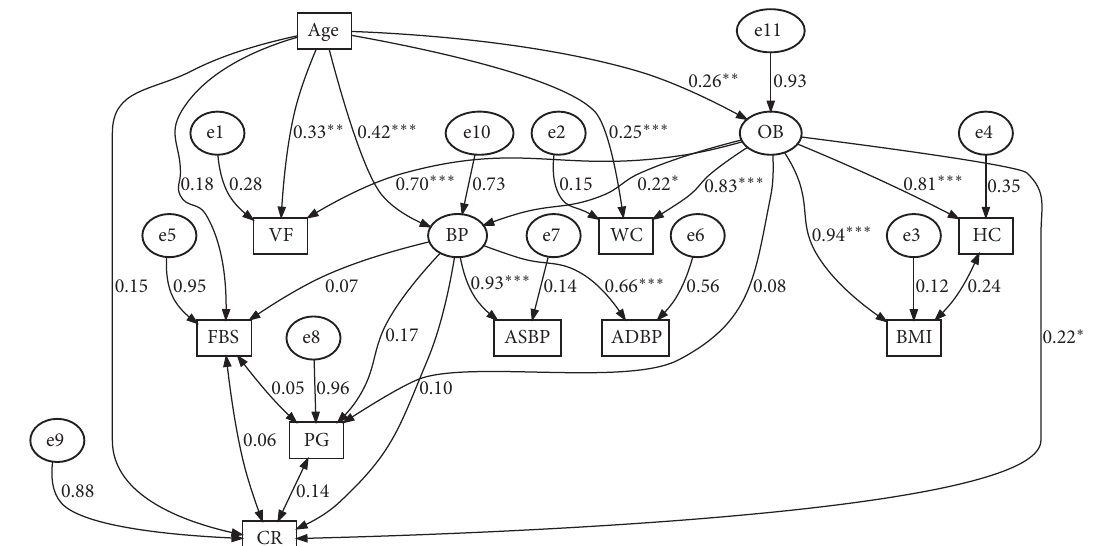
Figure 2: Structural equation model showing the effects of obesity and blood pressure on diabetes and coronary risk (Model 1). ∗∗∗ p value < 0 . 0001, ∗∗ p value < 0 . 01, and ∗ p value < 0 . 05.